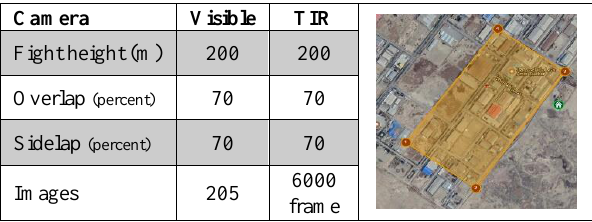
Table 2. Flight planning parameters.